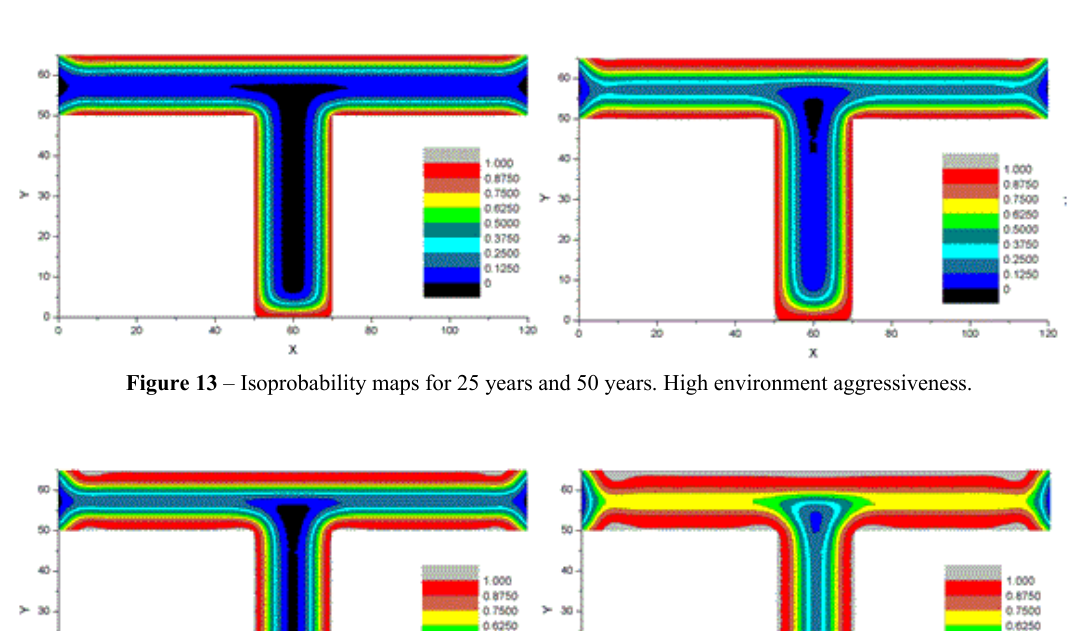
Figure 12 – Isoprobability maps for 25 years and 50 years. Normal environment aggressiveness.